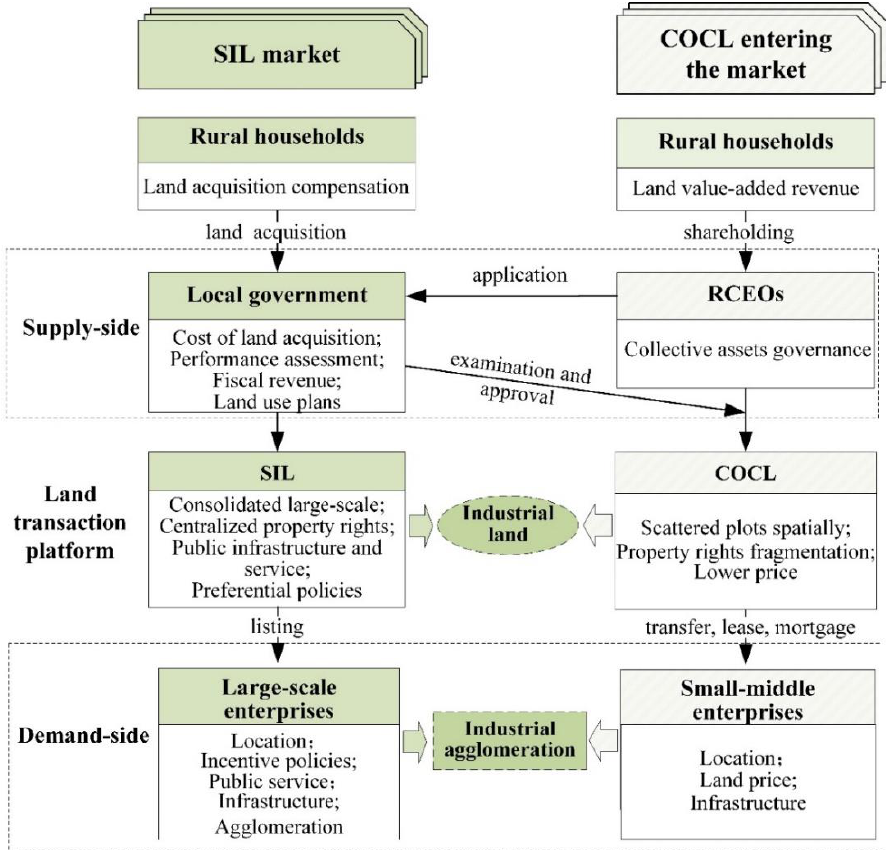
Figure 1. Relationship between SIL market and COCL entering the